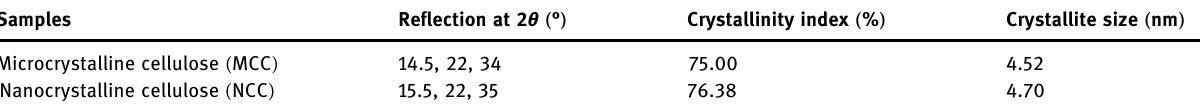
Table 3: XRD analysis for determining the crystallinity index ( CI ) and the crystallite size ( nm ) of MCC and NCC samples Samples